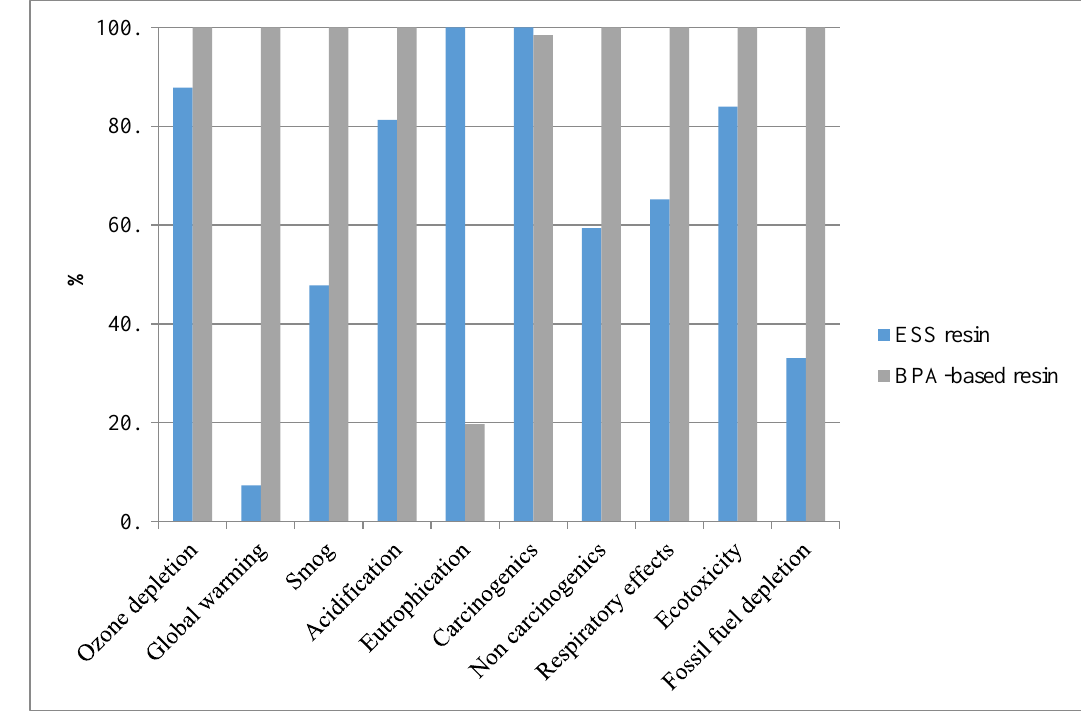
Figure 5. Comparing 1 kg ESS resin with 1 kg BPA-based resin.